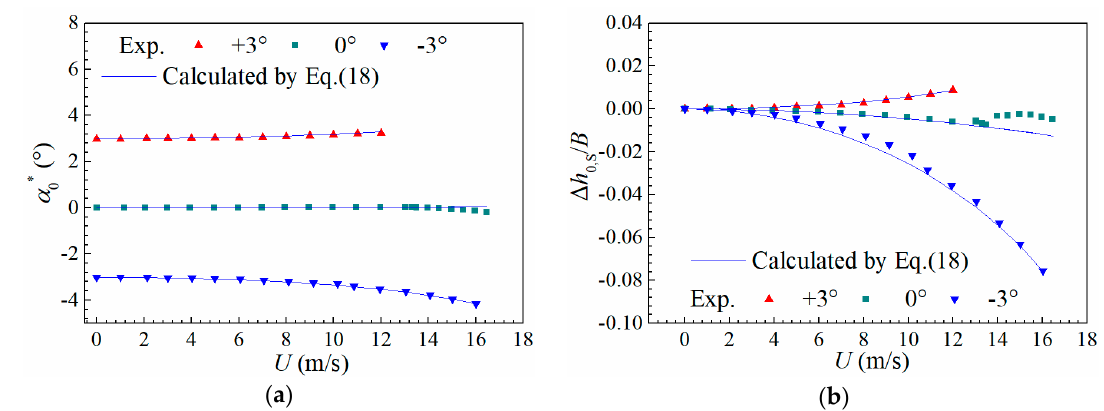
Figure 15. Static ( a ) torsional deformation and ( b ) heaving deformation of the sectional model versus wind speed.